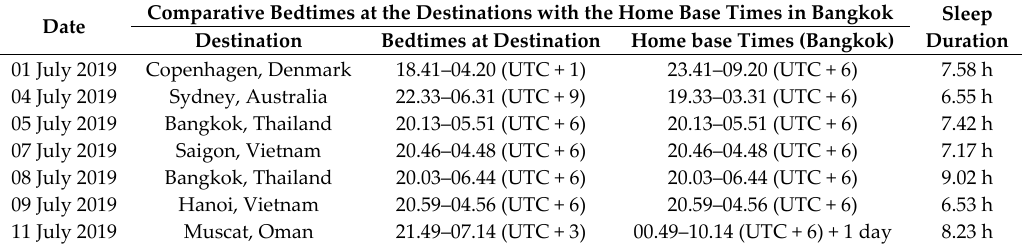
Table 11. Analyzed data from the Fitbit application of the 1st Female Flight Attendant.